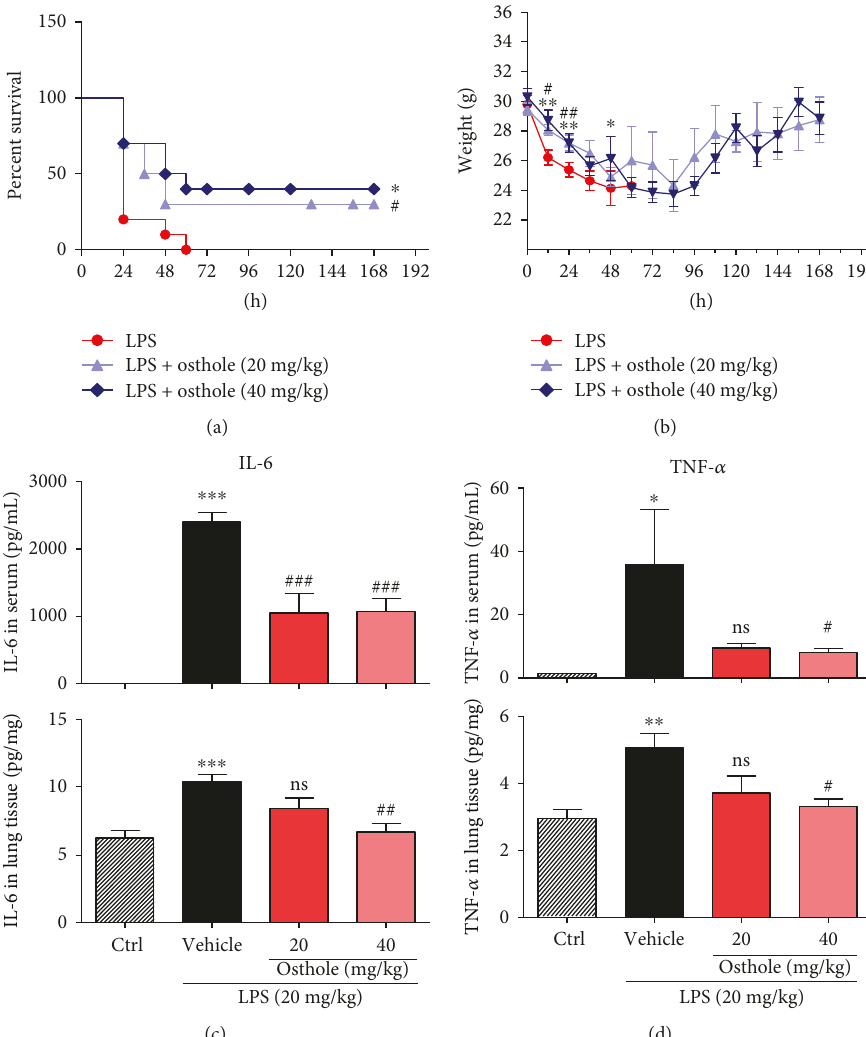
Figure 3: Osthole prolongs survival and inhibits in fl ammatory cytokines in LPS-induced septic mice. C57BL/6 mice ( n = 10 each group) were pretreated for 0.5h with 20 mg/kg or 40 mg/kg osthole via ip injection, followed by 20mg/kg LPS by iv injection. (a) Percent survival for up to 168 h post-LPS injection is reported as mean ± SEM ; n = 3 ; ∗ , p < 0 05 , versus control (Ctrl), and # p < 0 05 , versus LPS. (b) Body weight change was monitored for up to 168h post-LPS injection and reported as mean ± SEM ; n = 3 ; ∗ p < 0 05 and ∗∗ p < 0 01 , versus Ctrl; # p < 0 05 and ## p < 0 01 , versus LPS. ELISA determination of (c) IL-6 and (b) TNF- α content in serum and lung tissue from septic mice; values are normalized to serum volume (c) or tissue weights (d) and reported as mean ± SEM ; ns=not signi fi cant, ∗ p < 0 05 , ∗∗ p < 0 01 , and ∗∗∗ p < 0 001 , versus Ctrl. # p < 0 05 , ## p < 0 01 , and ### p < 0 001 , versus